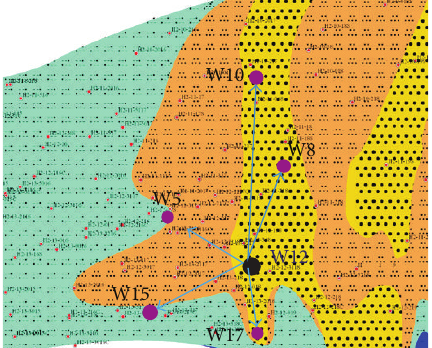
Figure 11: Distribution of injection wells and oil